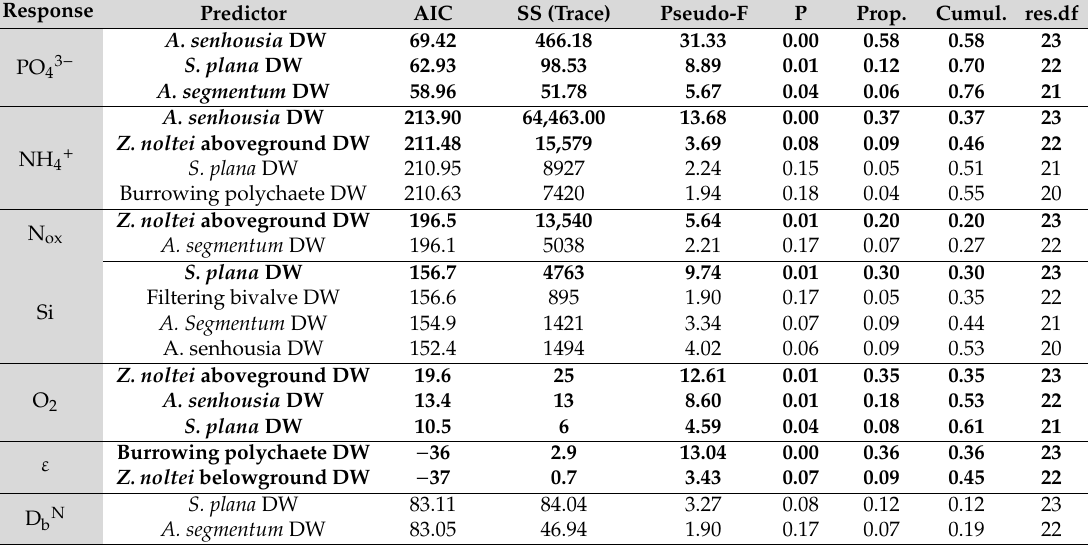
Z. noltei aboveground